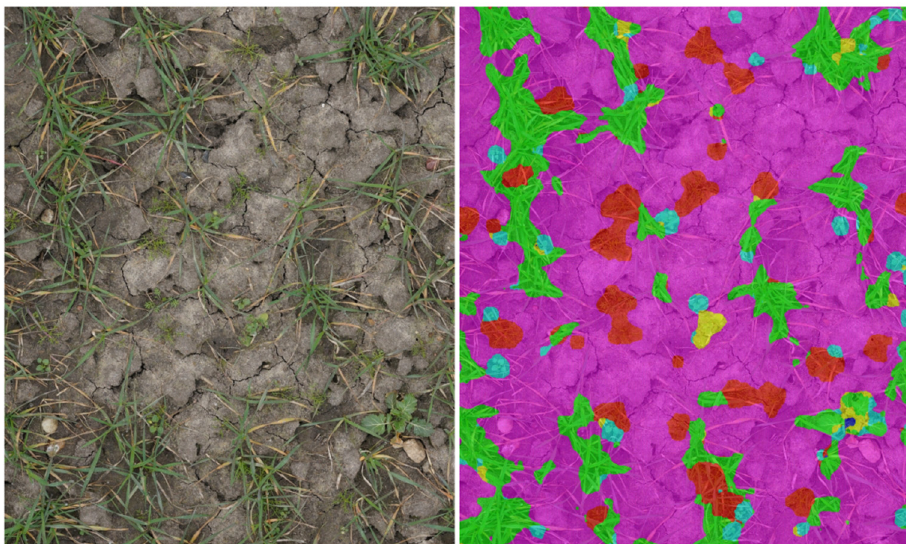
Figure 9. UAV aerial image with wheat crop and weed as zoomed in representation ( left ). In transparent colors ( right ): Superimposed classification resulting from the output of the ResNet-18 model with the optimized prediction routine running on an embedded system for the same UAV scene for comparison. The class labels are shown in different colors: SOIL (pink), TRZAW (green), MATCH (red), VERHE (yellow), VIOAR (light blue), and PAPRH (dark blue).